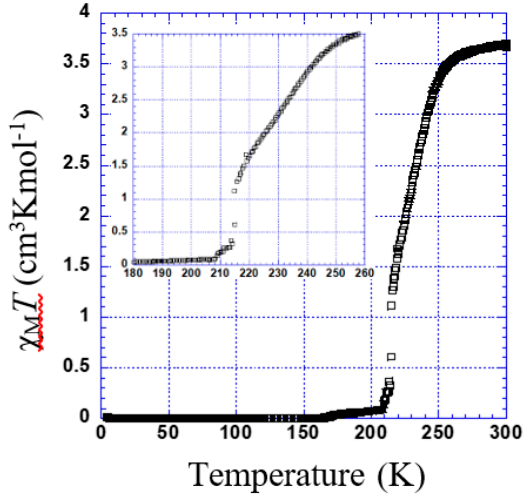
χ M T plot for 4 . Inset shows the temperature range of 180 to 260